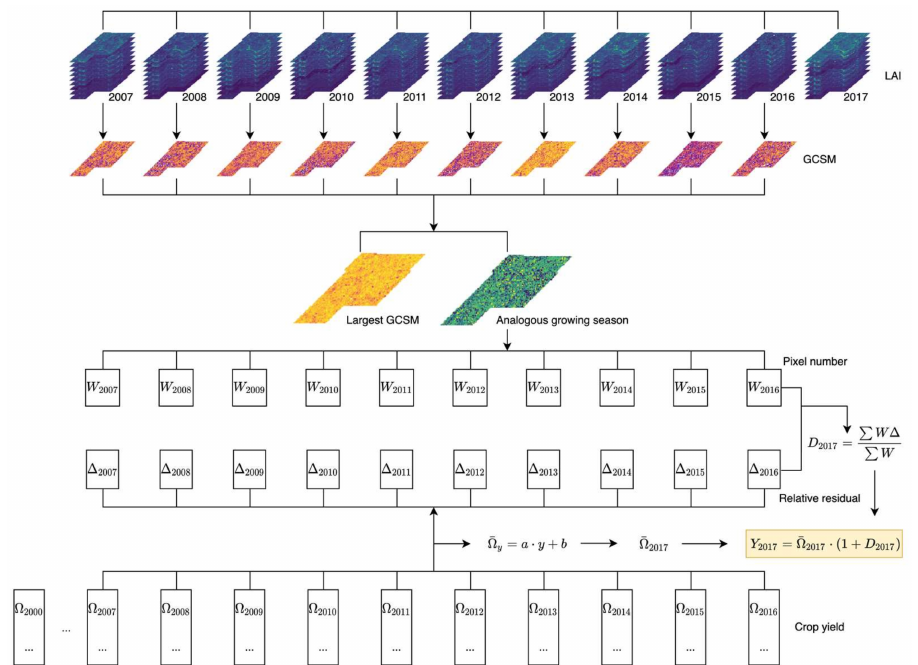
Figure 2. A schematic process of the forecast of crop yield in an example with Grunty county, Iowa, in 2017. The regional average yield Ω in 2017 was predicted extending the trend line derived from crop yield records during 2000–2016 across the entire region. An analogous growing season to 2017 is identified to have the maximum value of the generic composite similarity measure (GCSM) between time series of leaf area index (LAI) data by pixel. The total number of pixels for each analogous year, which are denoted by W , are determined for the past 10 years. The relative residual D in 2017 is determined to be the weighted average of the relative residuals in the analogous years, which is denoted by ∆ . The crop yield Y is finally forecasted by combing the estimated values of regional average and relative